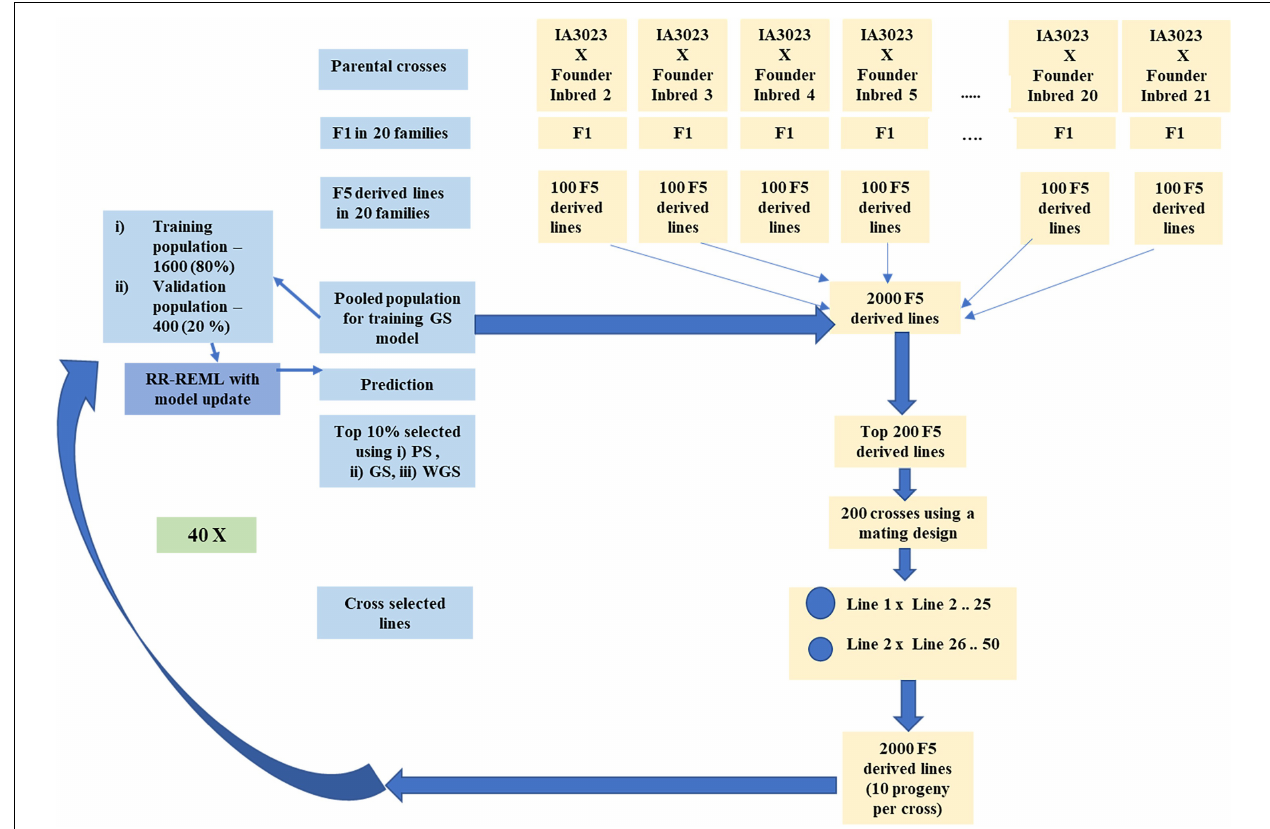
FIGURE 2 | Schematic representing simulated recurrent selection in centralized populations comprising 20 families. The schematic depicts the in silico steps used to generate the base population of 2000 F 5 derived lines derived from 20 founder lines crossed to IA3023. The depiction includes the model training step and the recurrent steps of prediction, sorting, truncation selection, crossing, and generation of 2000 F 5 -derived lines for each cycle as well as the decision steps to check if the training set should be updated and if the recurrent process should be continued for another